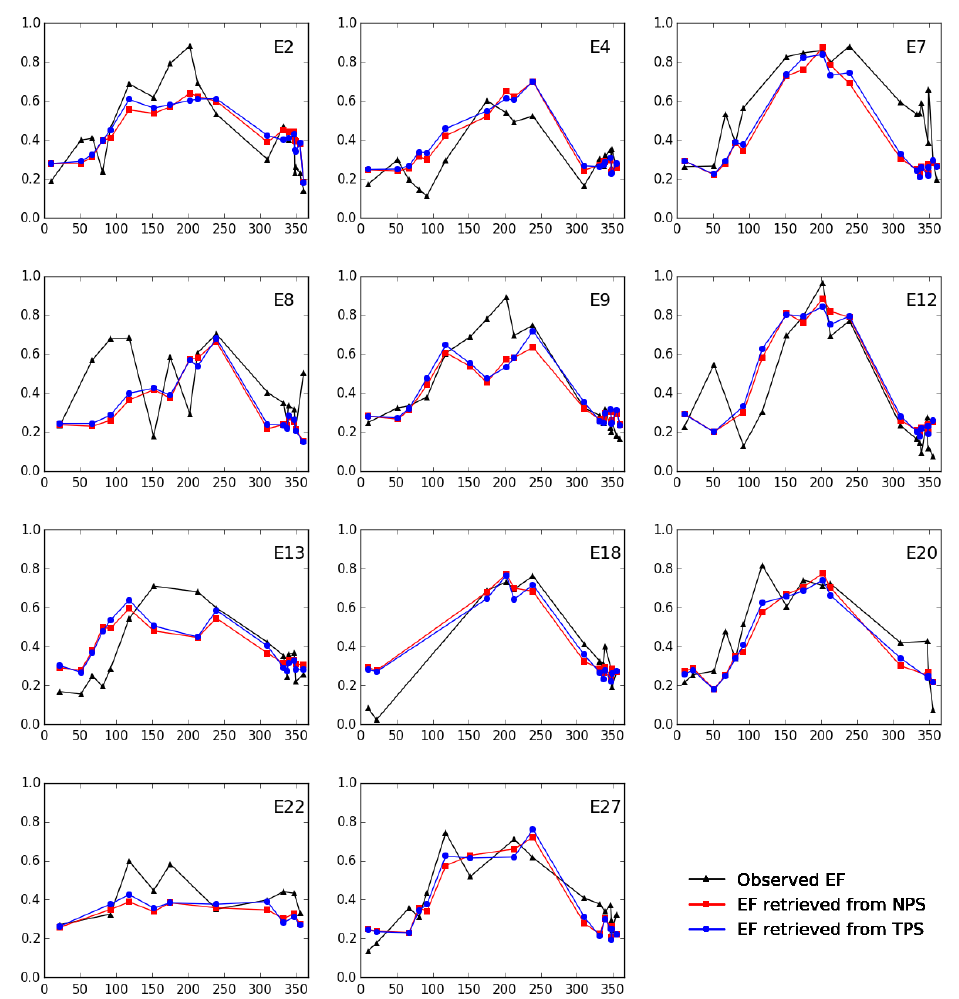
Figure 7. Temporal variations of observed EF and estimated EF generated by the TPS and NPS for 11